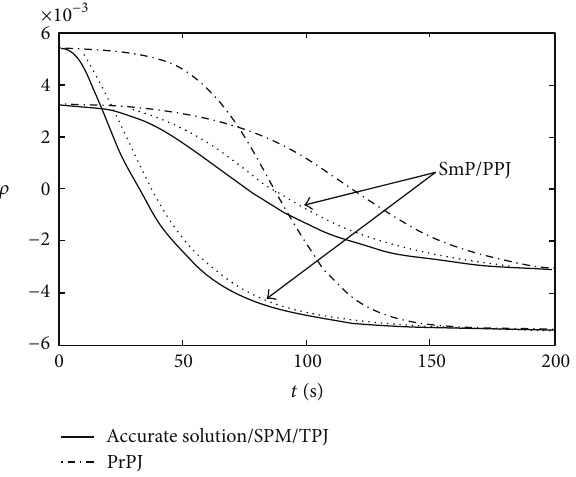
Figure 4: Variation of output power with reactivity while inserting step reactivity 𝜌 0 = 0.5𝛽 and 𝜌 0 = 0.8333𝛽 .